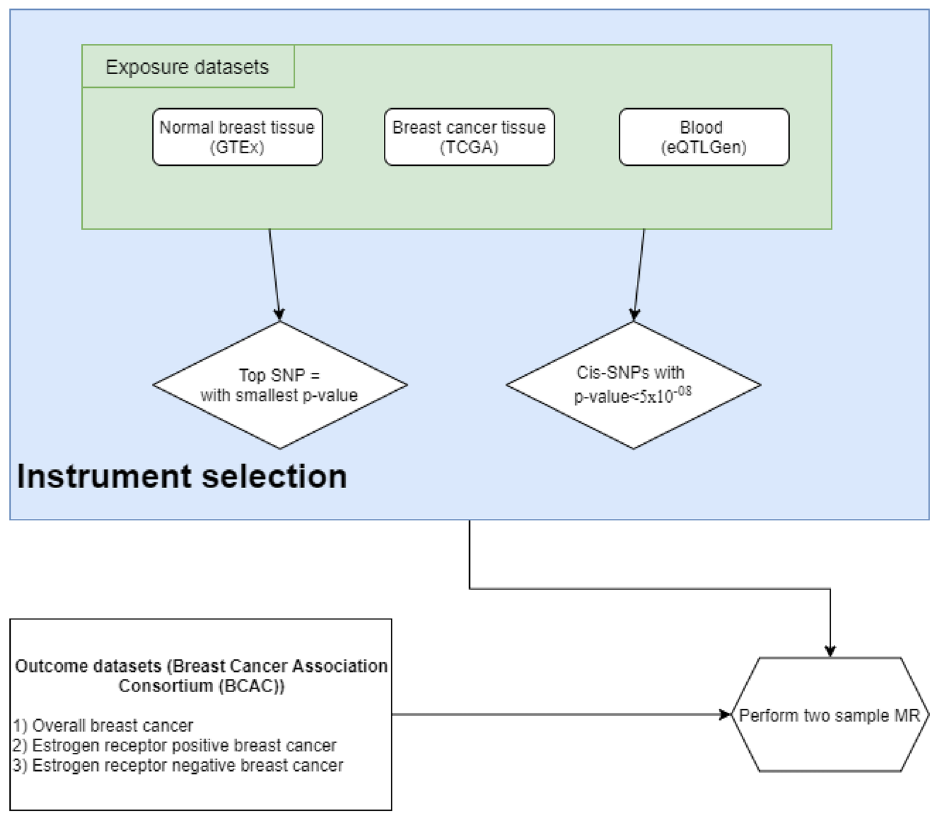
Figure 2. A diagramatic representation of the datasets included and the methodology is shown as a flow diagram.